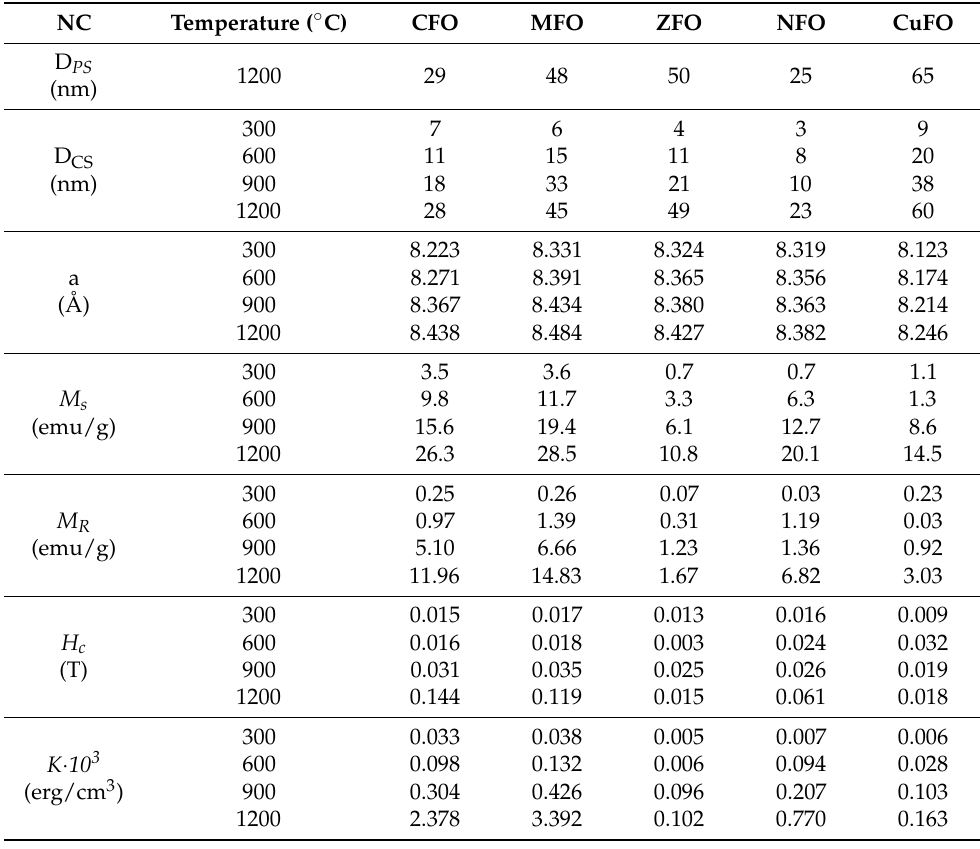
Table 2. Average particle size (D PS ), average crystallites size (D CS ), lattice parameter (a), saturation magnetization ( M s ), remanent magnetization ( M R ), coercivity ( H c ), and magnetic anisotropy constant (K) of CFO, MFO, ZFO, NFO, and CuFO NCs annealed at 300, 600, 900, and 1200 ◦